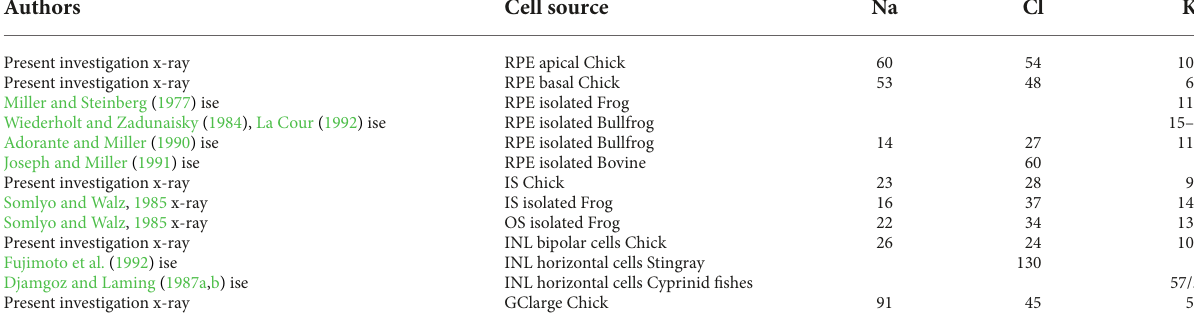
TABLE 2 Comparison of intracellular ion concentrations.